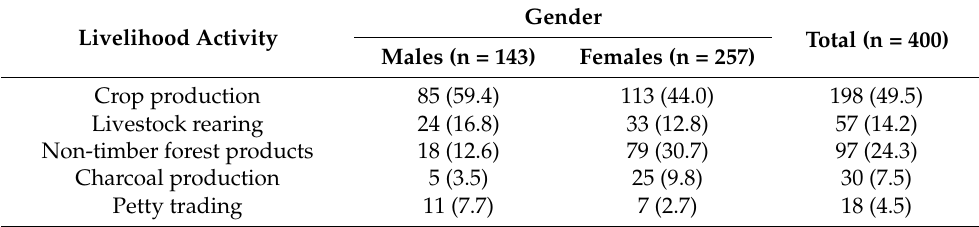
Table 4. Main livelihood activities of the study